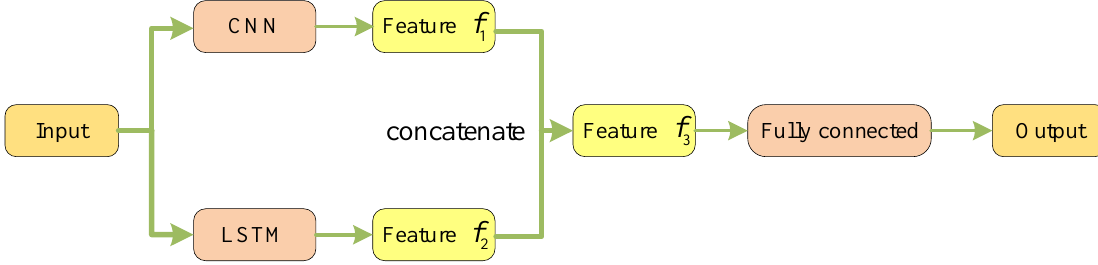
Figure 7. The architecture of the Convolutional Neural Network (CNN)-LSTM framework.